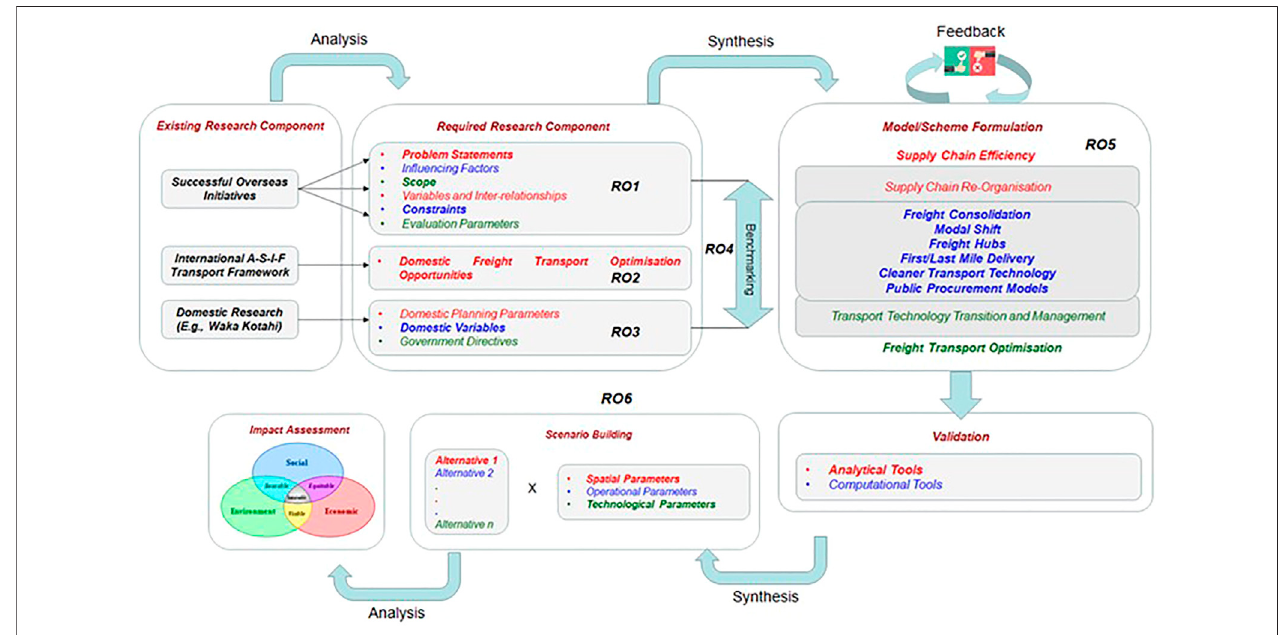
FIGURE 9 | Research objective components and linkages (Authors ’ conception).